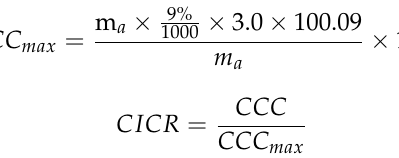
where CCC max is the theoretical maximum CCC in specimen.